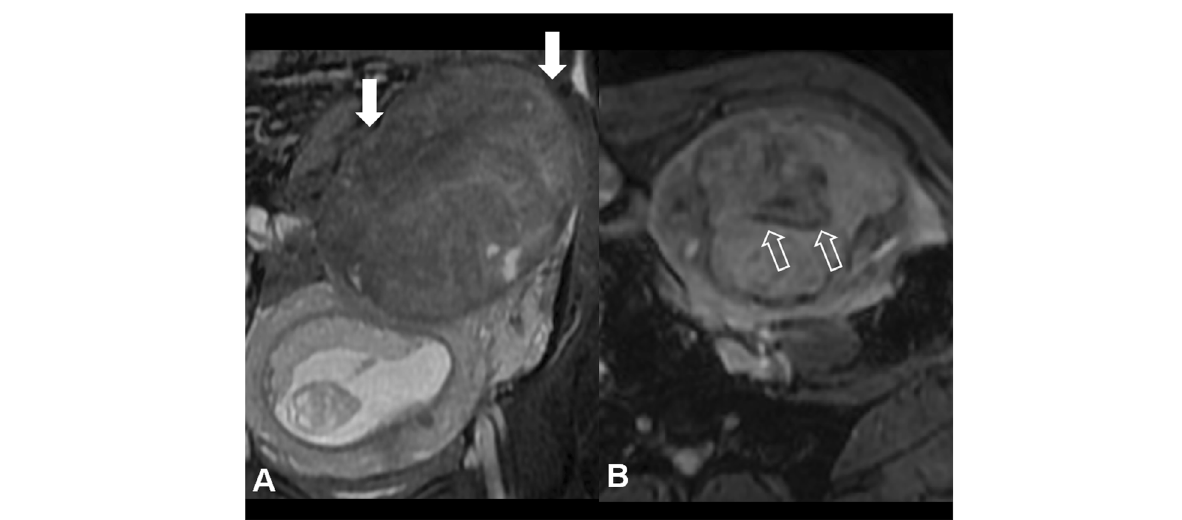
Fig. 4 A 31-year-old pregnant patient with abdominal pain. a Coronal T2W image shows a heterogeneous sub-serosal fibroid in the fundus (arrows). b Axial gradient image (GRE) shows areas of hemorrhage within (open arrows) suggesting red degeneration. The patient was